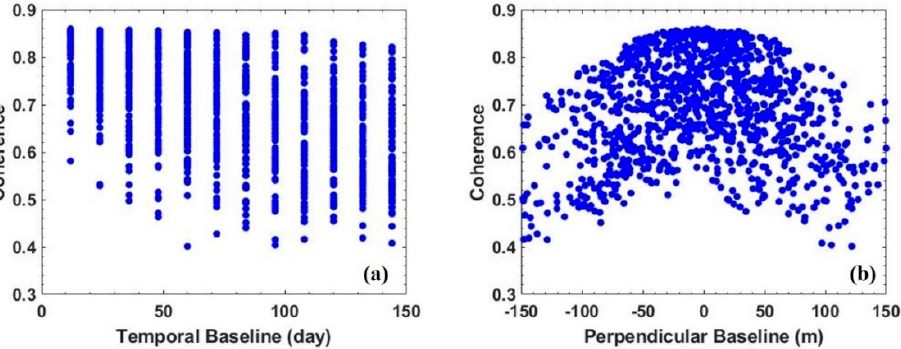
Figure A2. Scatter plot of average coherence of candidate interferograms vs. their ( a ) temporal and ( b ) perpendicular baseline, respectively.